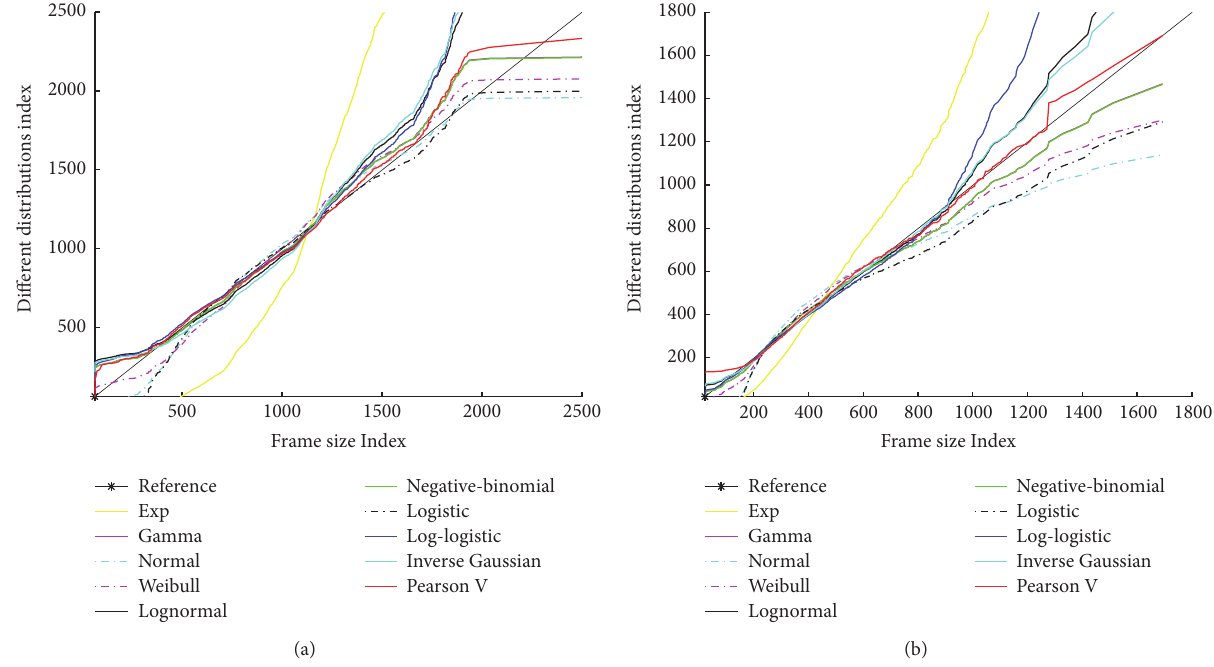
Figure 3: (a) The Q-Q plot for I frame, base layer of NBC News. (b) The Q-Q plot for B frame, base layer of NBC News.